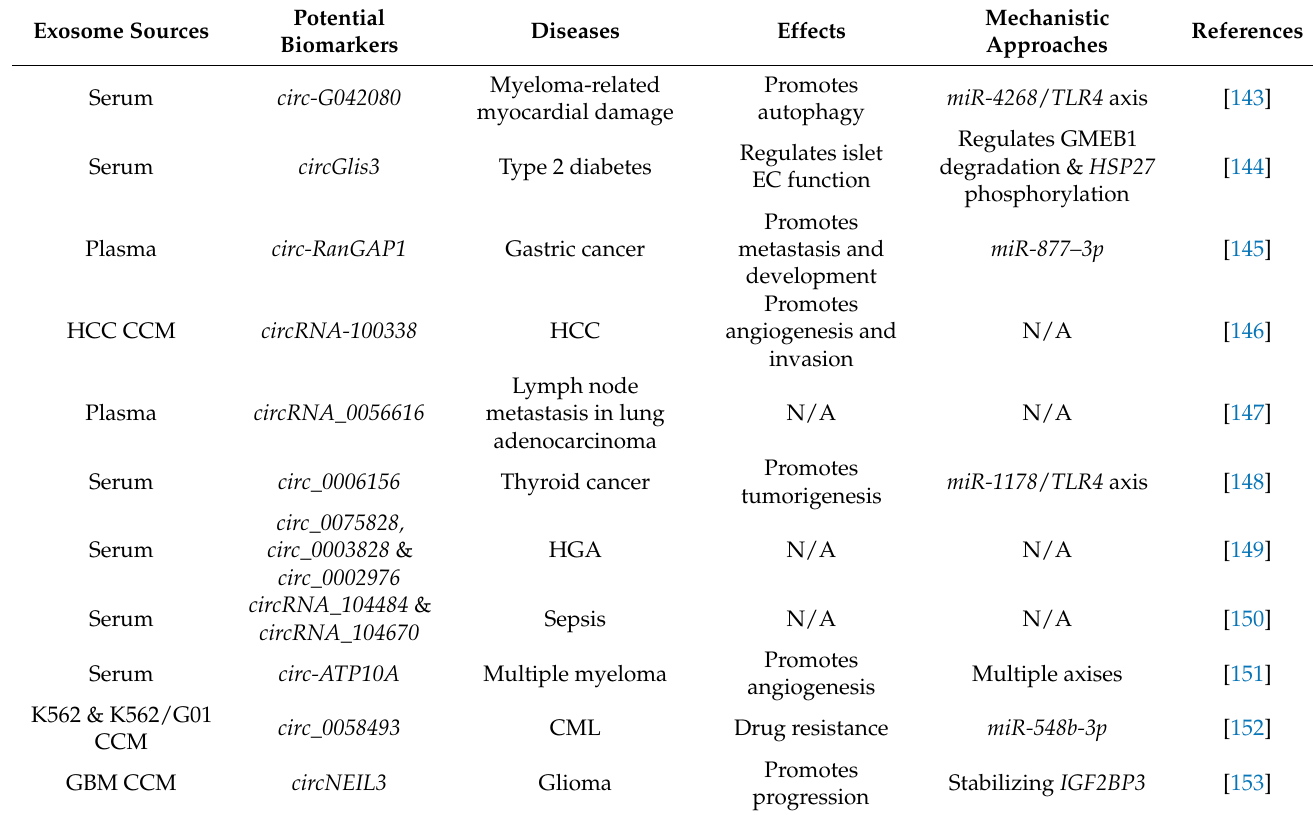
Table 4. Summary of exosomal circRNAs as potential disease